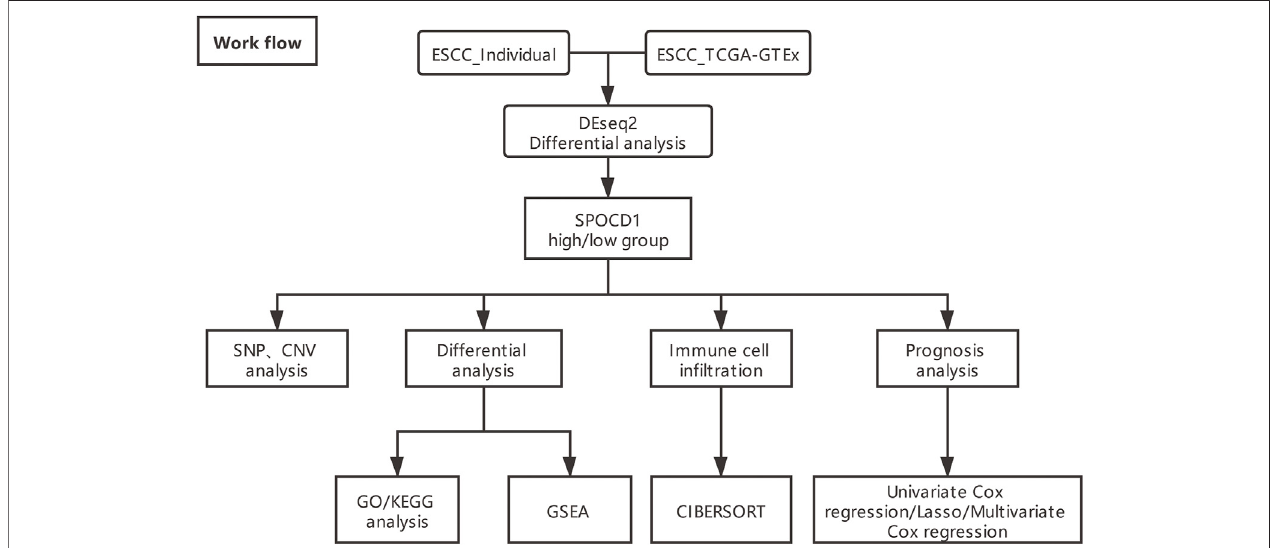
FIGURE 1 | The overall analysis fl ow chart (ESCC_Individual is self-test data). ESCC, esophageal squamous cell carcinoma; TCGA, The Cancer Genome Atlas; SPOCD1, SPOC Domain Containing 1; SNP, single nucleotide polymorphism; CNV, copy number variation; GO, Gene Ontology; KEGG, Kyoto Encyclopedia of Genes and Genomes; GSEA, gene set enrichment